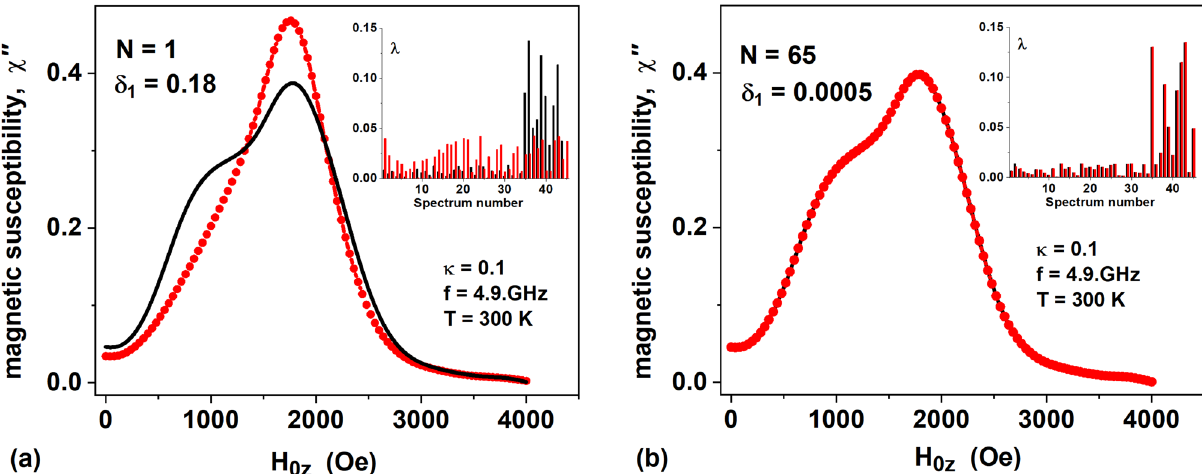
Figure 6. Application of a genetic algorithm to determine the volume fractions of basic assemblies of magnetite nanoparticles from a given FMR spectrum of a certain dilute composite assembly: ( a ) the first iteration of the genetic algorithm, N = 1, ( b ) the final iteration, N = 65. The insets in the figures show the given distribution of volume fractions λ i (0) (black bars) and the current distribution of volume fractions λ i (red bars), obtained at the first and final iterations of the genetic algorithm,